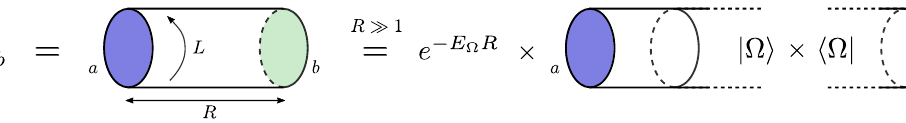
Figure 4 . The g -function and the cylinder partition function in 2d QFT. When the length of the cylinder is large R (cid:29) 1, the partition function can be approximated by the overlaps between the boundary states and the ground state. This allows us to compute the g -functions in integrable QFTs by taking the limit of the cylinder partition function, which in turn can be computed by the Thermodynamic Bethe